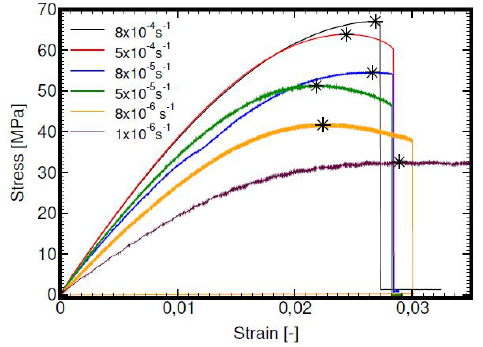
Figure 5. Creep experiments at various stress levels.